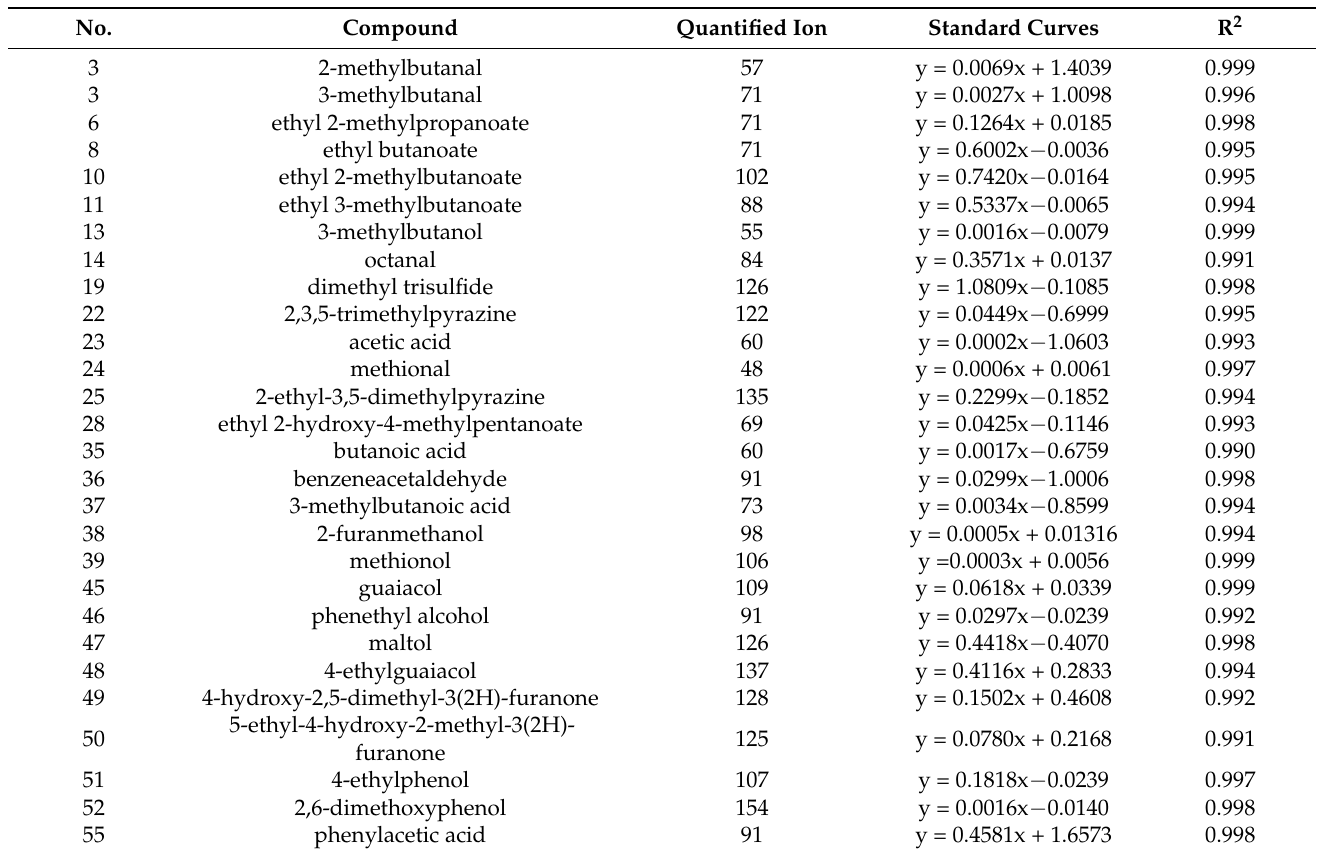
Table 3. Standard curves of 28 odor-active compounds quantitated in six CSS